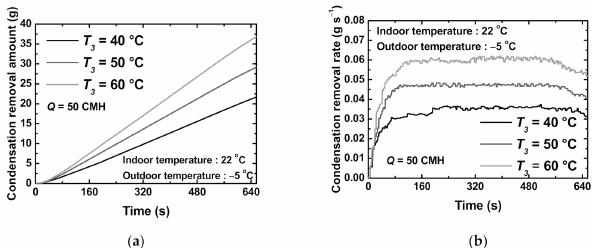
Figure 9. Result of Case 3 at various RA temperatures ( T 3 ): ( a ) condensation removal quantity; ( b ) condensation removal rate over time.